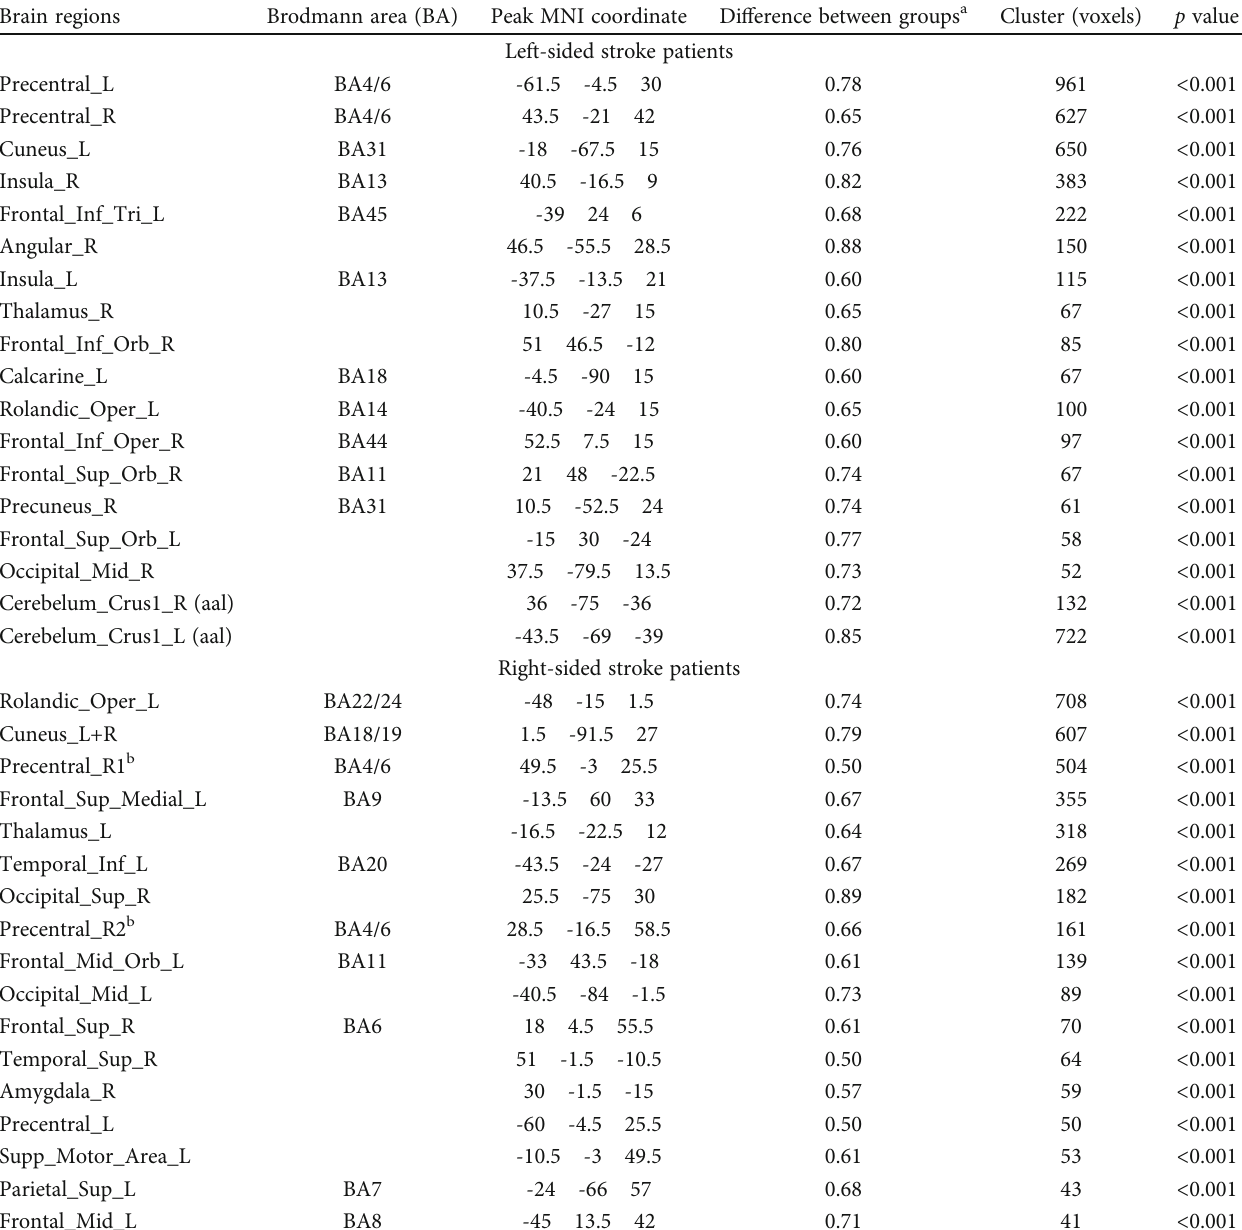
Table 3: Regions showing signi fi cant di ff erences in structural covariance when compared between stroke patients and healthy controls. Brain regions Brodmann area (BA) Peak MNI coordinate Di ff erence between groups a Cluster (voxels) p